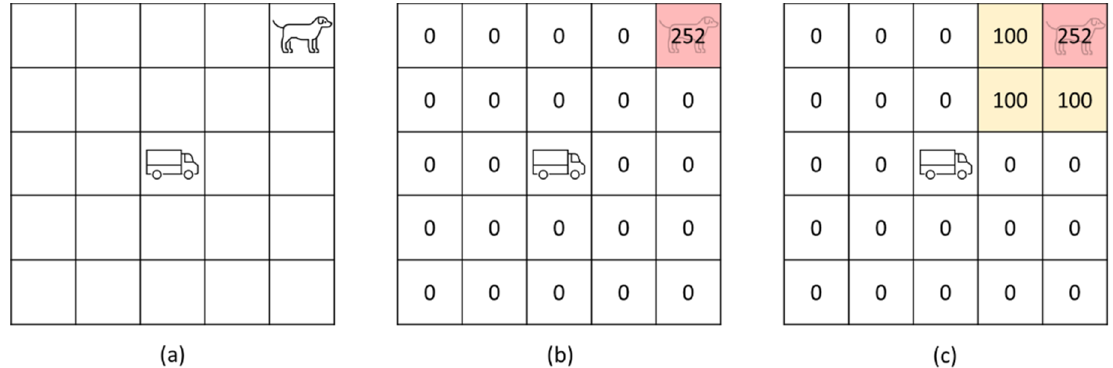
Figure 8. A simplified example of a Keep-Standoff-Distance perceptual schema behavior: ( a ) the world state, with the autonomous vehicle in the center, and an obstacle being detected in the upper right-hand corner; ( b ) costmap with LiDAR readings; ( c ) final behavioral costmap, with the perceptual schema increasing the costs in the area directly around the obstacle.